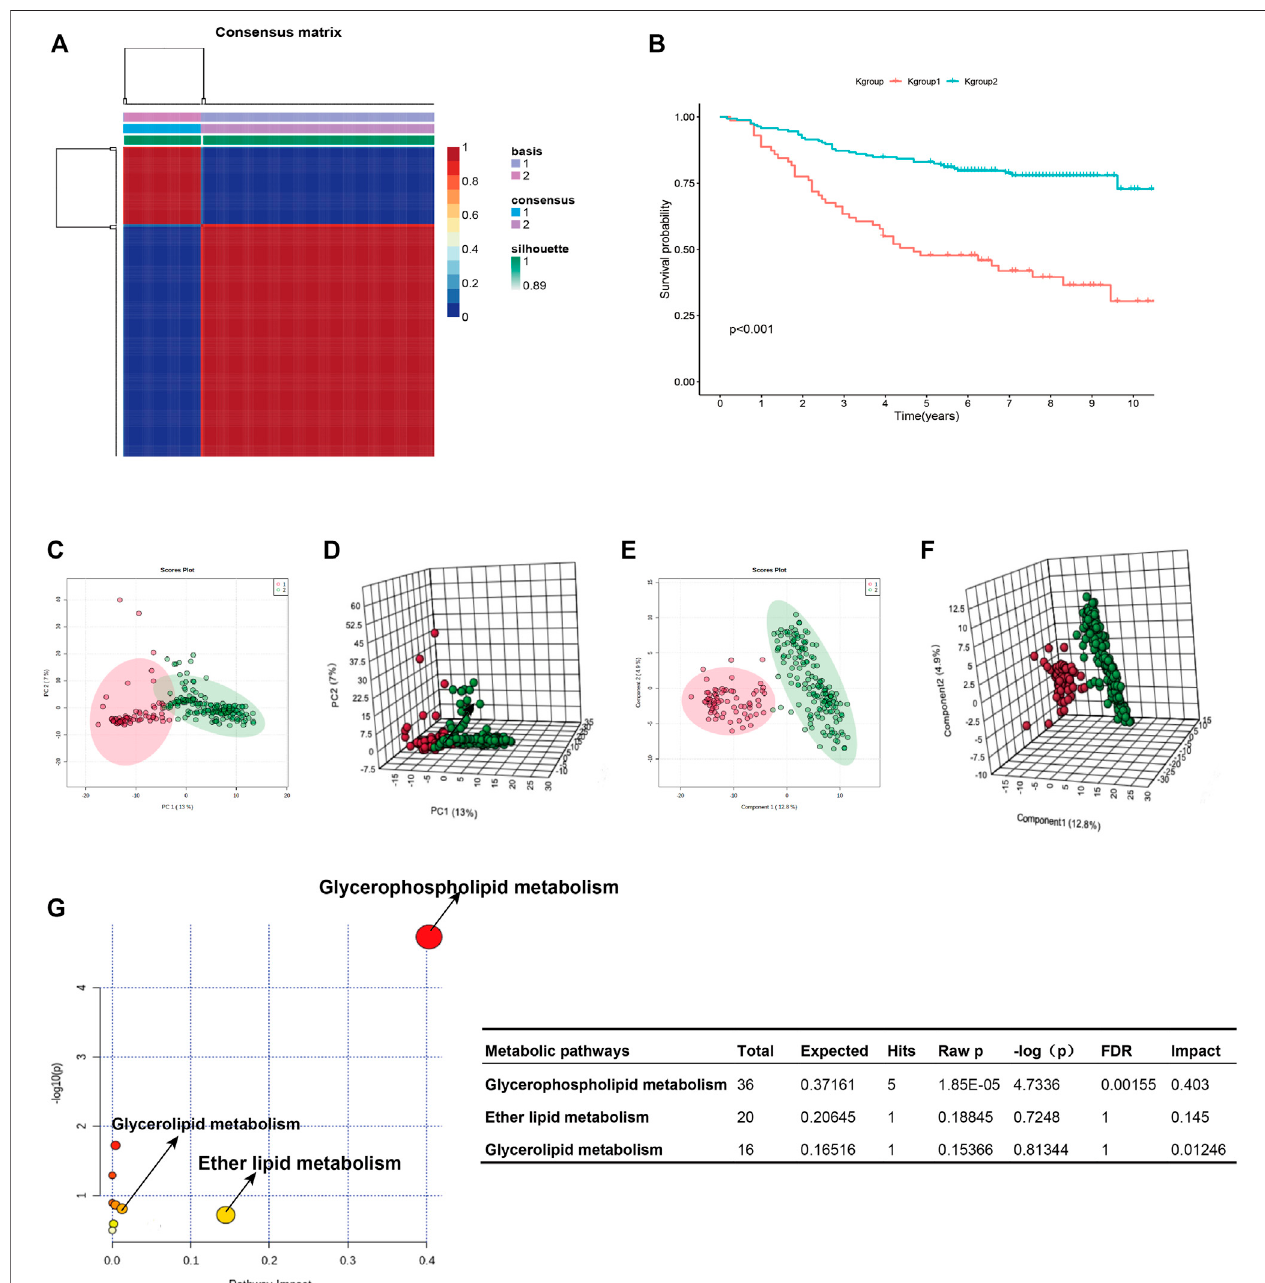
FIGURE 2 | K-group1 and K-group2 are independent with each other. (A) : K-means clustering heatmap of K-group1 and K-group2. (B) : The K-M survival curves indicated that the overall survival of JLUFH CRC patients in K-group 1 was lower than that in K-group2. (C,D) : Two-dimensional and three-dimensional PCA plots for K-group1 and K-group2. (E,F) : Two-dimensional and three-dimensional PLSDA plots for K-group1 and K-group2. (G) : The KEGG functional enrichment analysis for differential lipid metabolites.